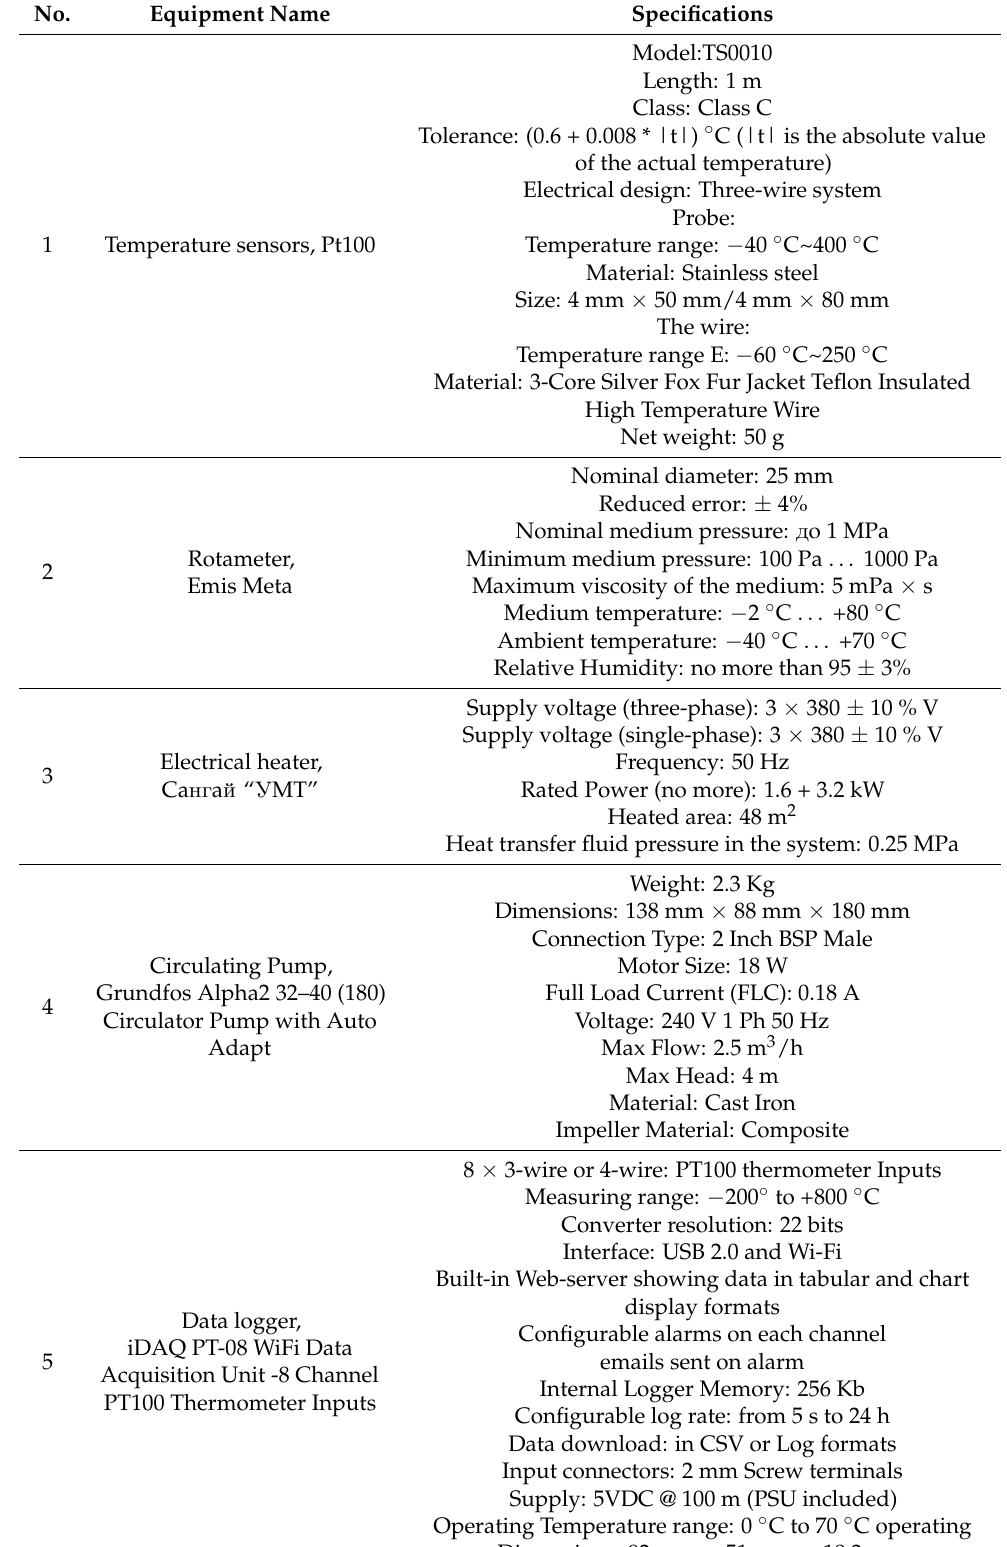
Table A1. Thermal response test measurement device